Question: Name the type of graph shown.
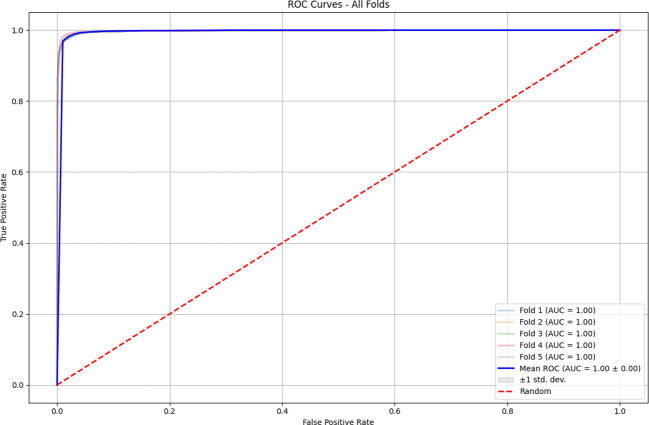
Answer: line